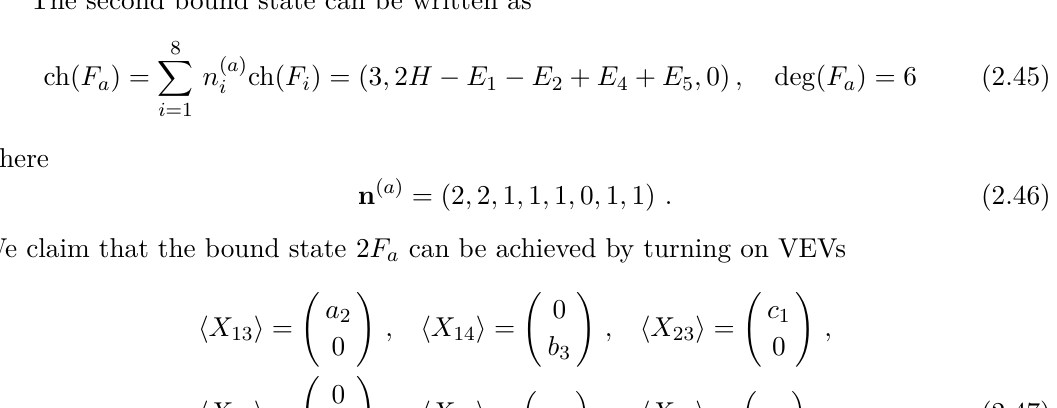
In the oriented model, we have 48 Goldstone modes which leaves us with 64 real scalars in adjoints of U(2)